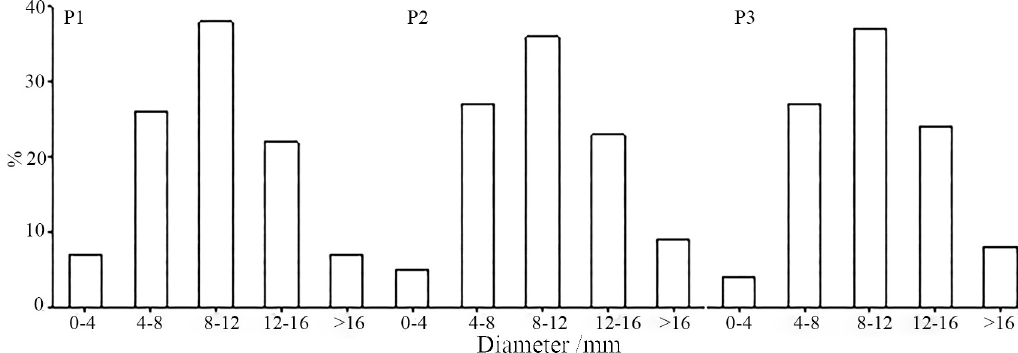
Fig 3. Distribution of Salix psammophila diameters on different